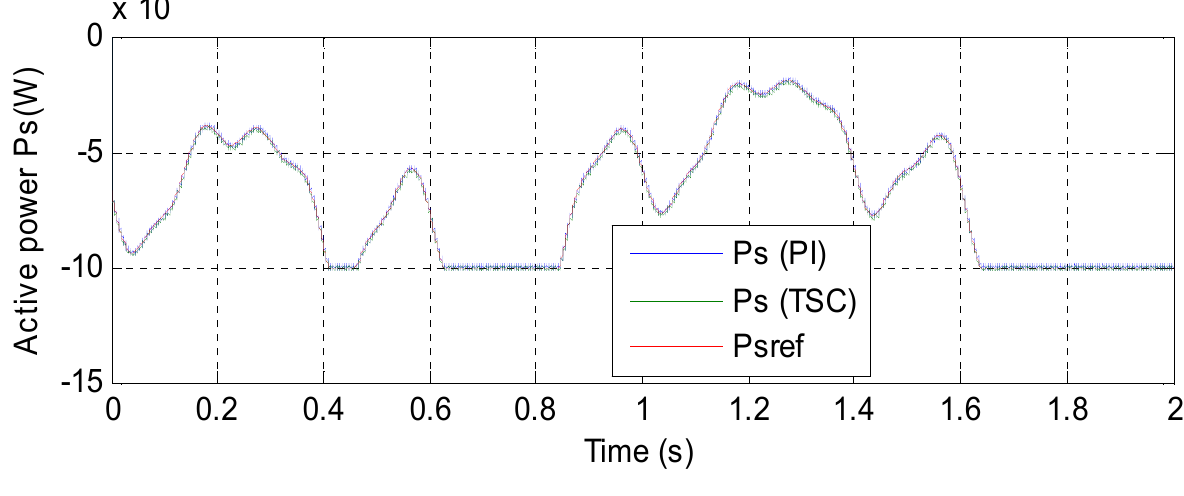
Figure 8. Active Figure 8. Active power.